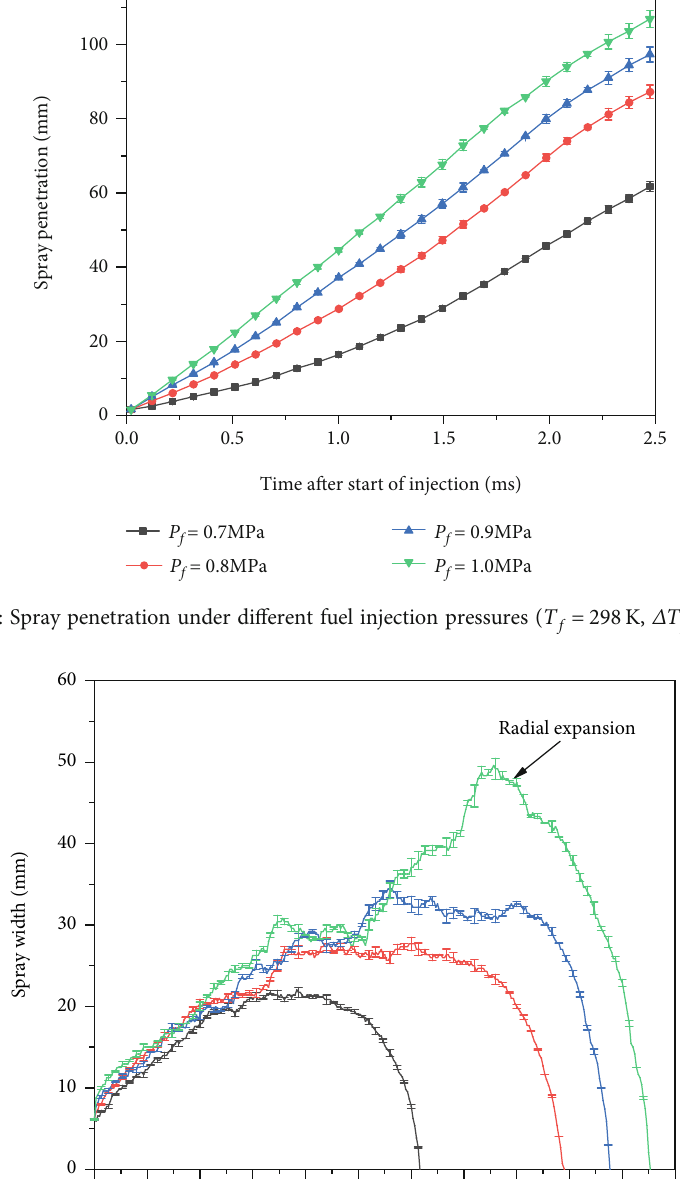
Figure 9: Spray width at di ff erent axial positions under di ff erent fuel injection pressures ( t = 2 : 5ms , T